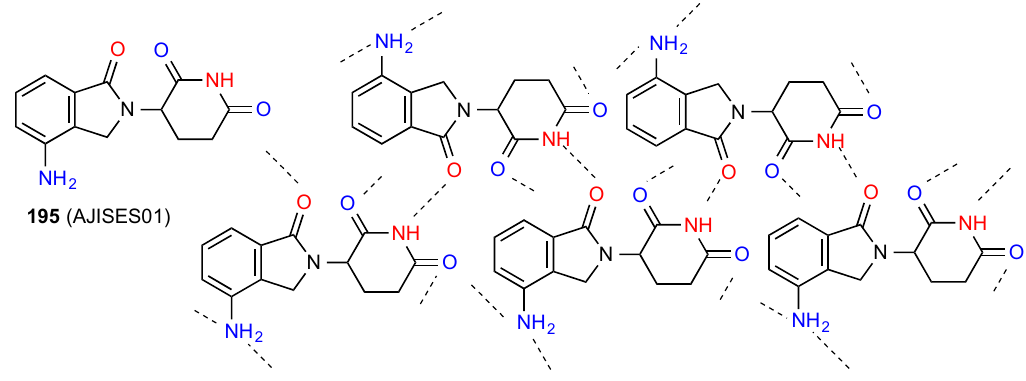
Figure 58. Structure adopted by compound 195.